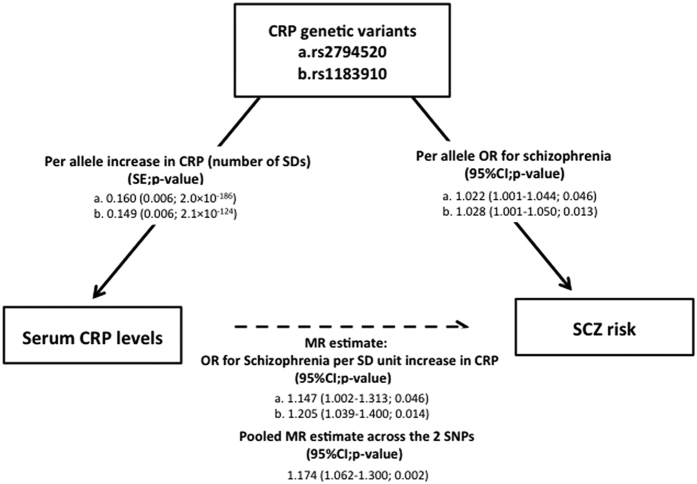
Mendelian randomization analysis.Both a Mendelian randomization estimate based on each SNP (rs2794520 and rs1183910) and a pooled Mendelian randomization estimate across these 2 SNPs showed significant effects of CRP levels on schizophrenia risk (p = 0.046, p = 0.014, and p = 0.0017, respectively).